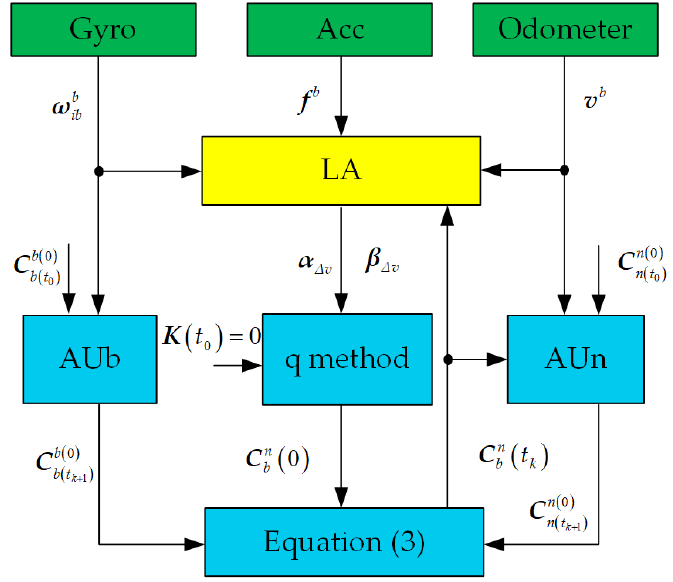
Figure 1. The block diagram of the proposed ICA